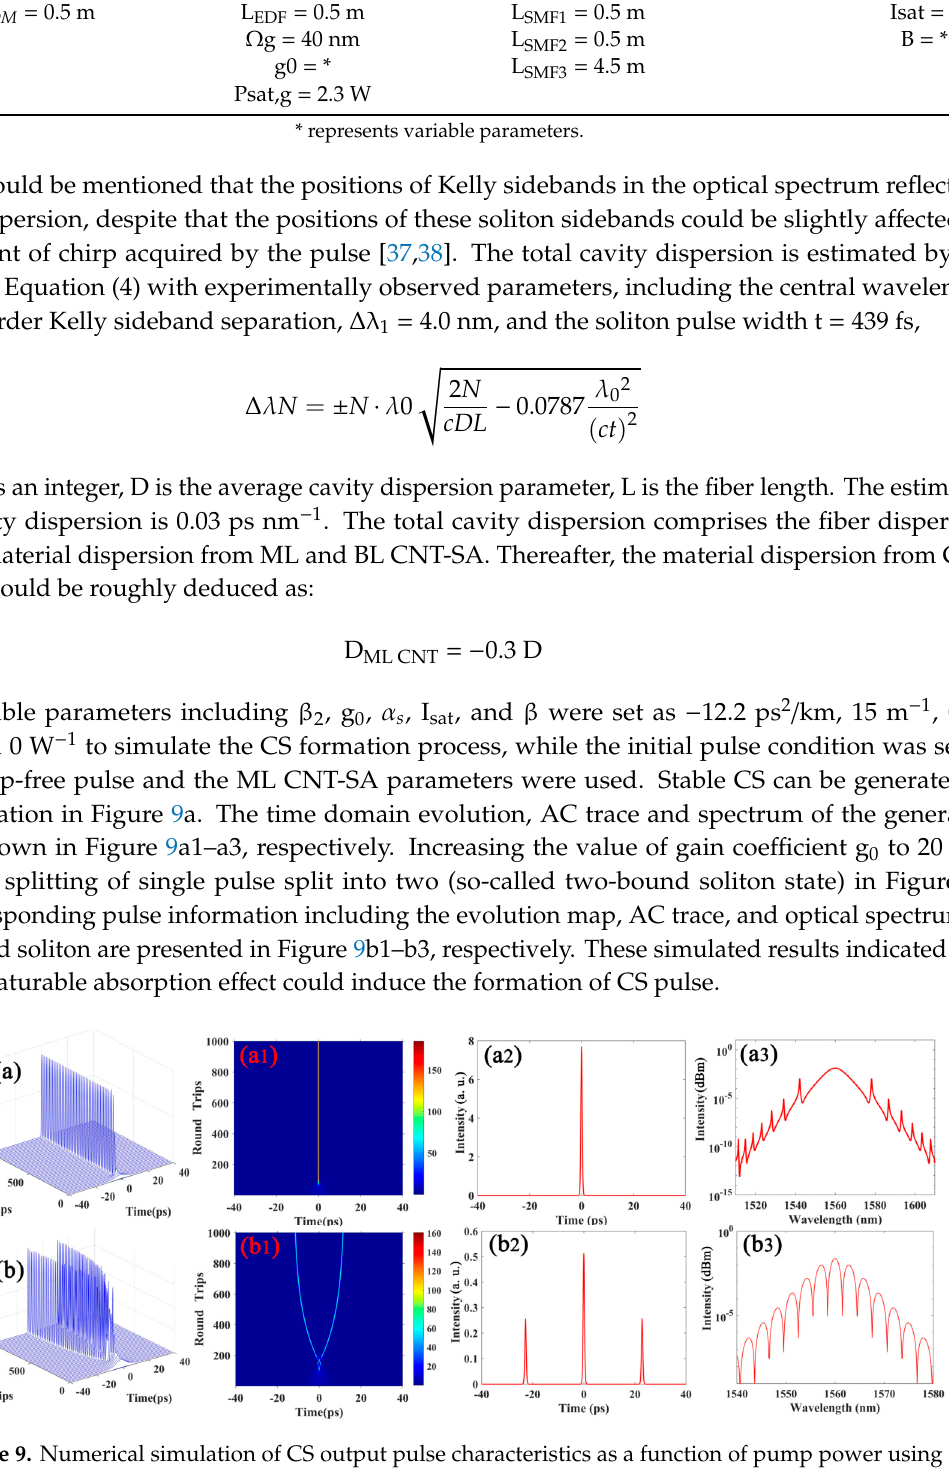
Figure 9. Numerical simulation of CS output pulse characteristics as a function of pump power using the ML CNT-SA parameters. ( a ) Single CS pulse evolution; ( b ) two-bound soliton state evolution; ( a1 )–( a3 ) are the simulated time evolution, AC trace and optical spectrum of the CS; ( b1 )–( b3 ) are the simulated time evolution, AC trace and optical spectrum of the two-bound soliton, respectively.